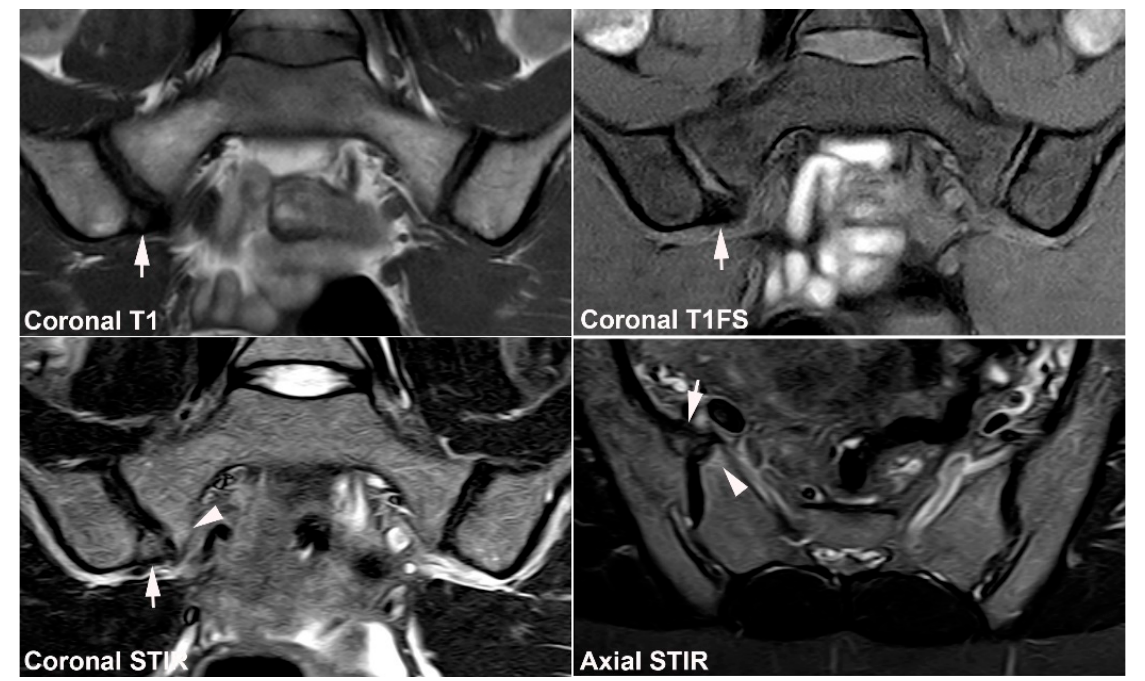
Figure 11. Unfused nucleus at the border between S1 and S2. MRI in a 30-year-old woman with intermittent low back pain; semi-coronal T1, T1FS and STIR, and semi-axial STIR images at the border between S1 and S2. There is persistence of a nucleus in the right joint space (arrows) accompanied by subchondral edema in the adjacent sacral bone (arrowheads).